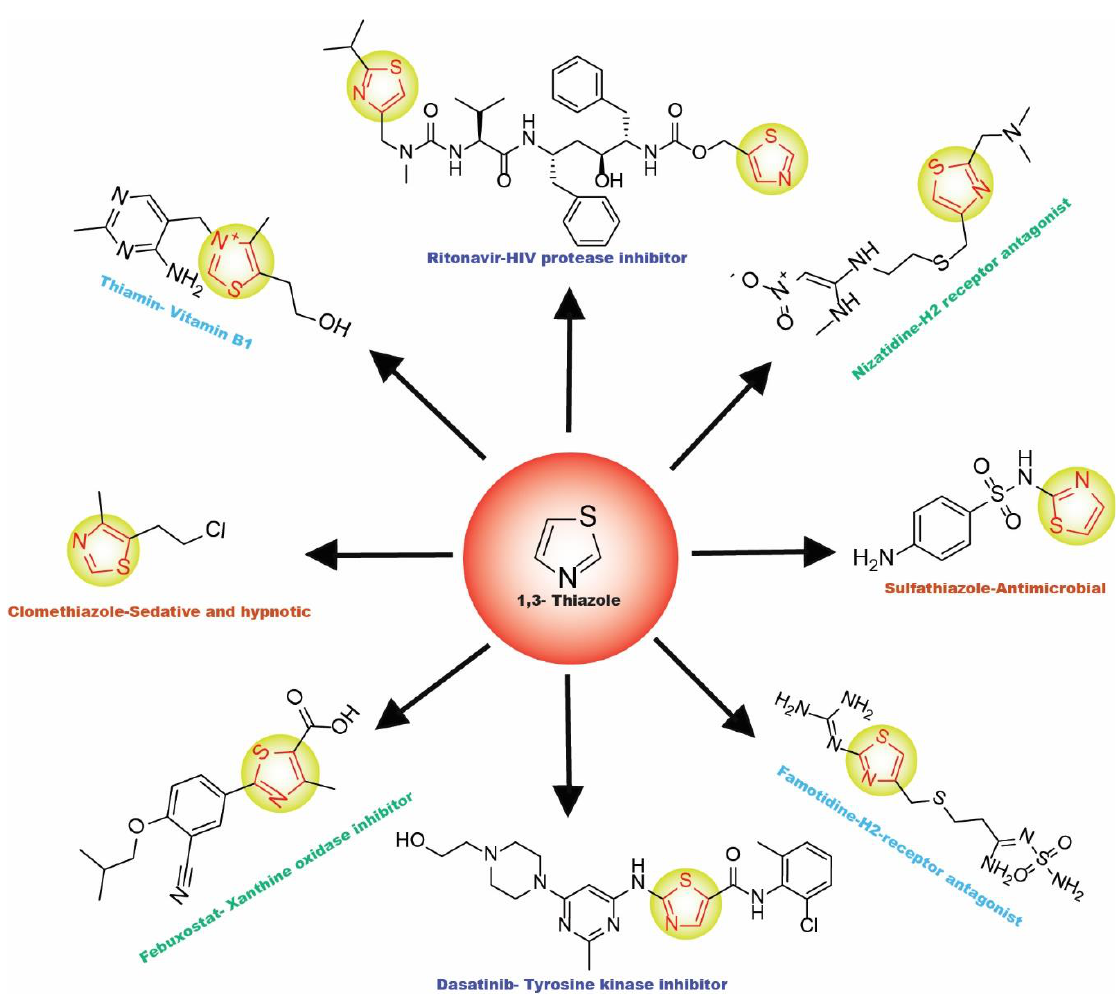
Figure 1. Some of the active pharmaceutical ingredients bearing thiazole ring.